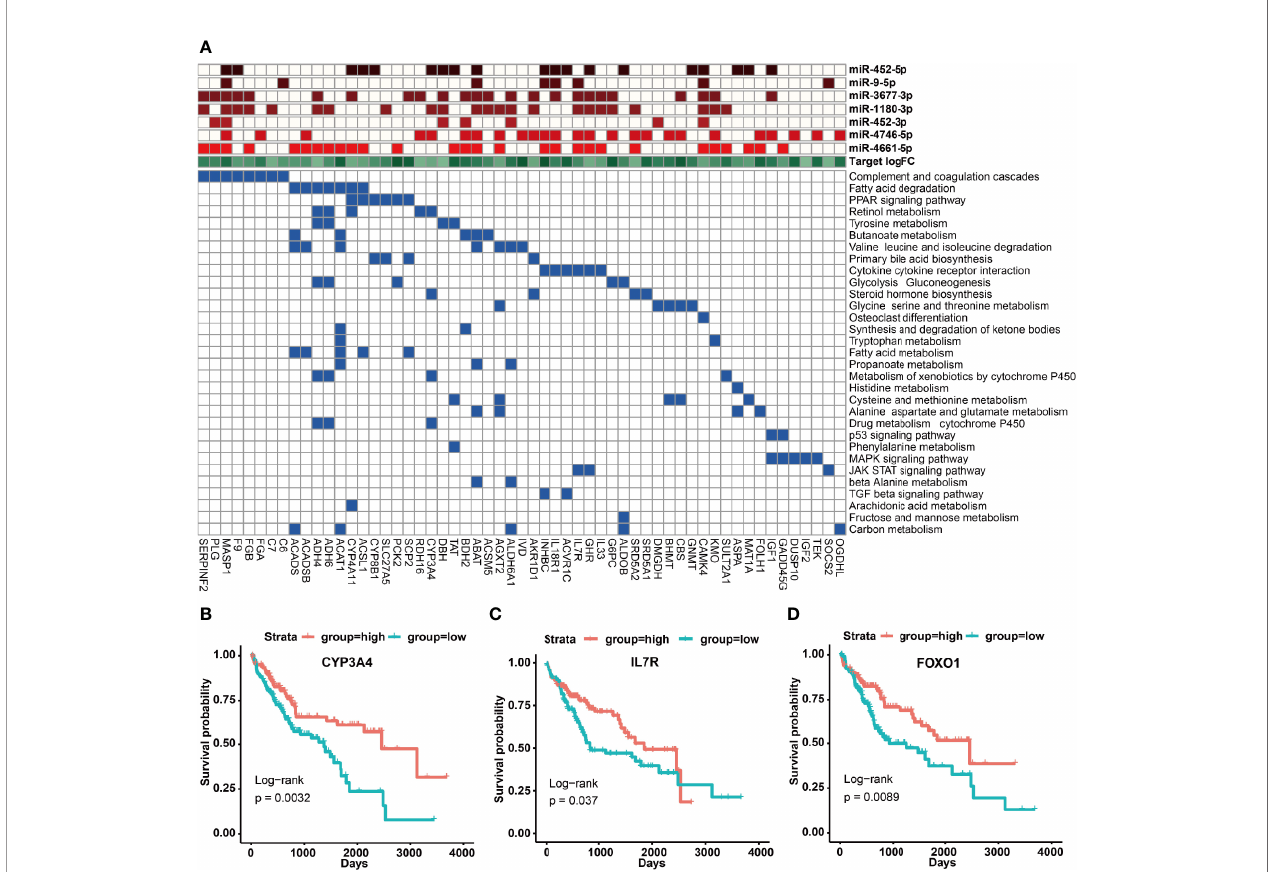
FIGURE 5 | KEGG signaling pathways of down-regulated target genes and their regulation by miRNAs. (A) KEGG signaling pathways involved in survival-related down-regulated target genes and their regulation by miRNAs. (B – D) The impact of up-regulated target genes on the overall survival rate of HCC patients, taking CYP3A4, IL7R and FOXO1 as